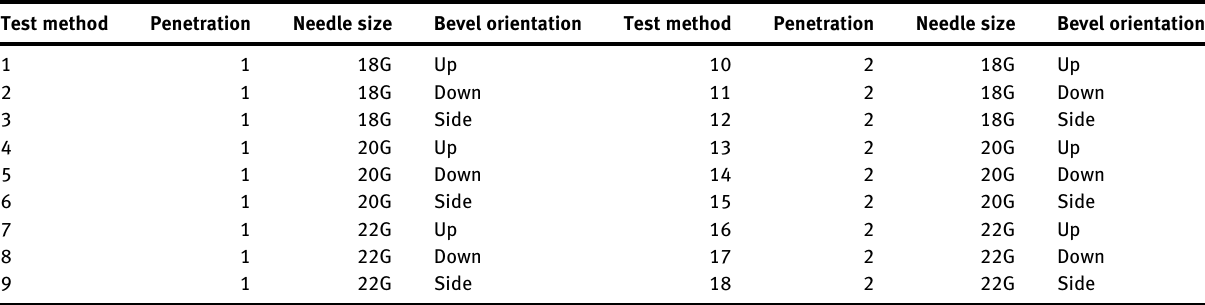
Table  : Testing method